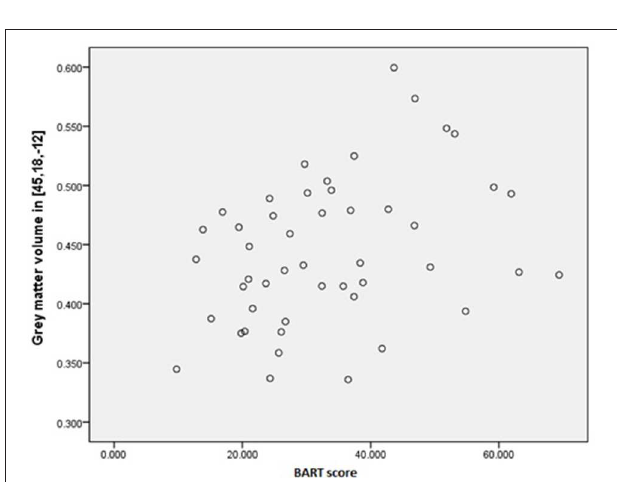
FIGURE 4 | Interaction between AI and BART results. Positive correlation between Anterior Insula (AI), and the BART results (MNI coordinate [45 18 −